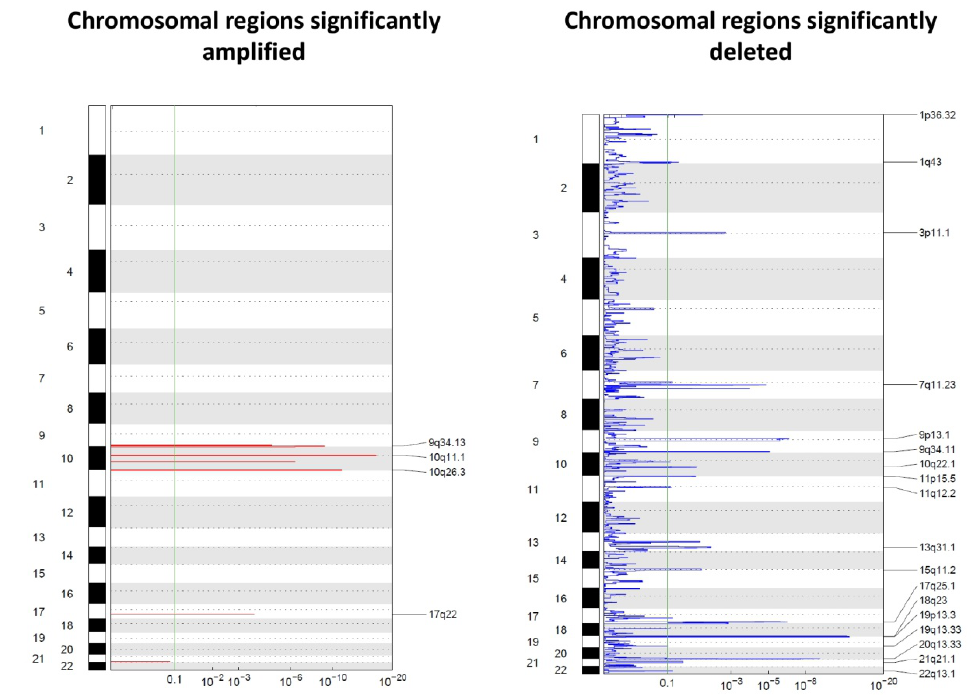
Figure 1. Genomic Identification of Significant Targets in Cancer (GISTIC) amplification (left) and deletion (right) plots on single CTCs. The genome is oriented vertically from top to bottom, and the GISTIC q -values at each locus are plotted from left to right on a log scale. The green line represents the significance threshold ( q -value = 0.1).